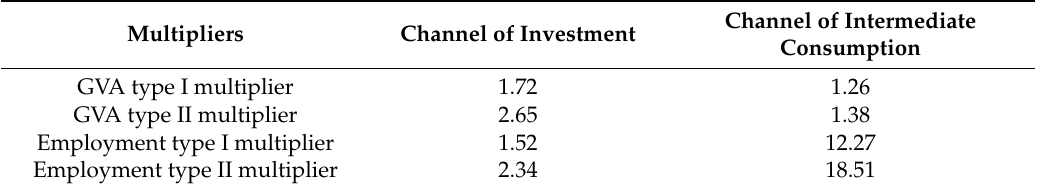
Table 2. Gross value added (GVA) and employment wind power plants type I and type II multipliers.